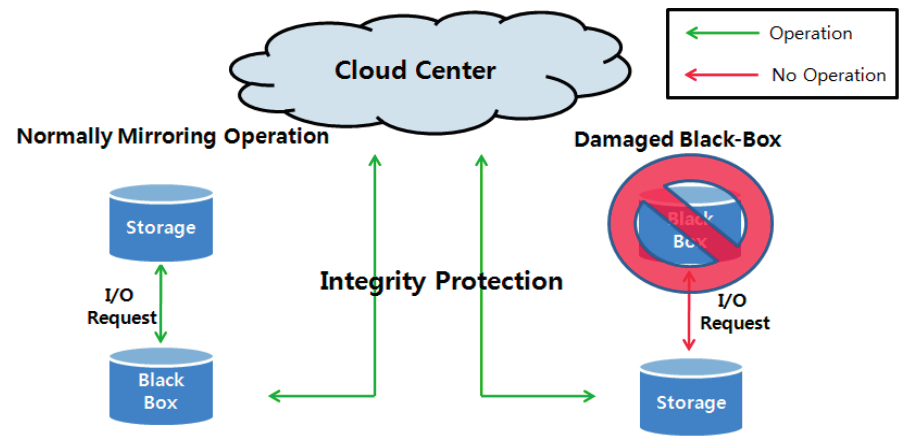
Figure 2. Mirroring operation for black box